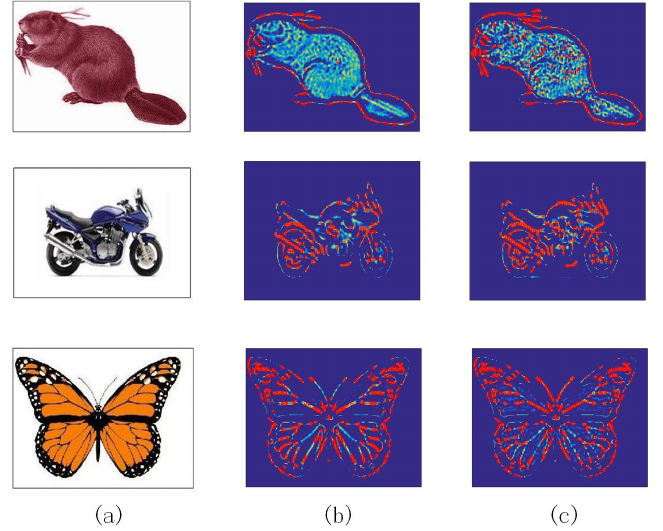
Figure 8. Quantitative experimental analysis of feature point extraction: ( a ) original image, ( b ) feature point extraction without Laplace filter, ( c ) feature point extraction with Laplace filter.